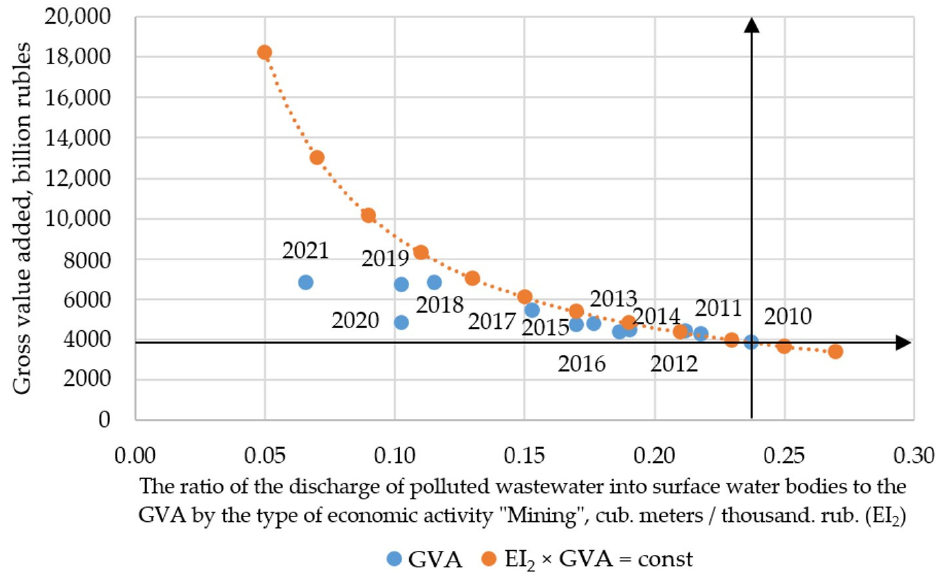
Figure 3. The color of environmental and economic development in terms of discharge of polluted wastewater into surface water bodies by type of economic activity “Mining” in the Russian Federation for the period 2010–2021.